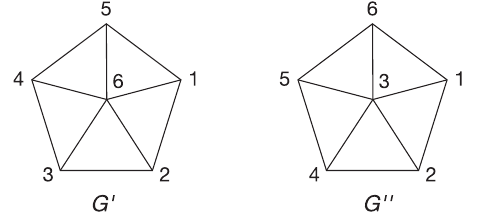
FIG. 3. Graphs G 0 and G 00 used in the definition of stabilizer states ϕ 0 and ϕ 00 ; see Eq. (11).